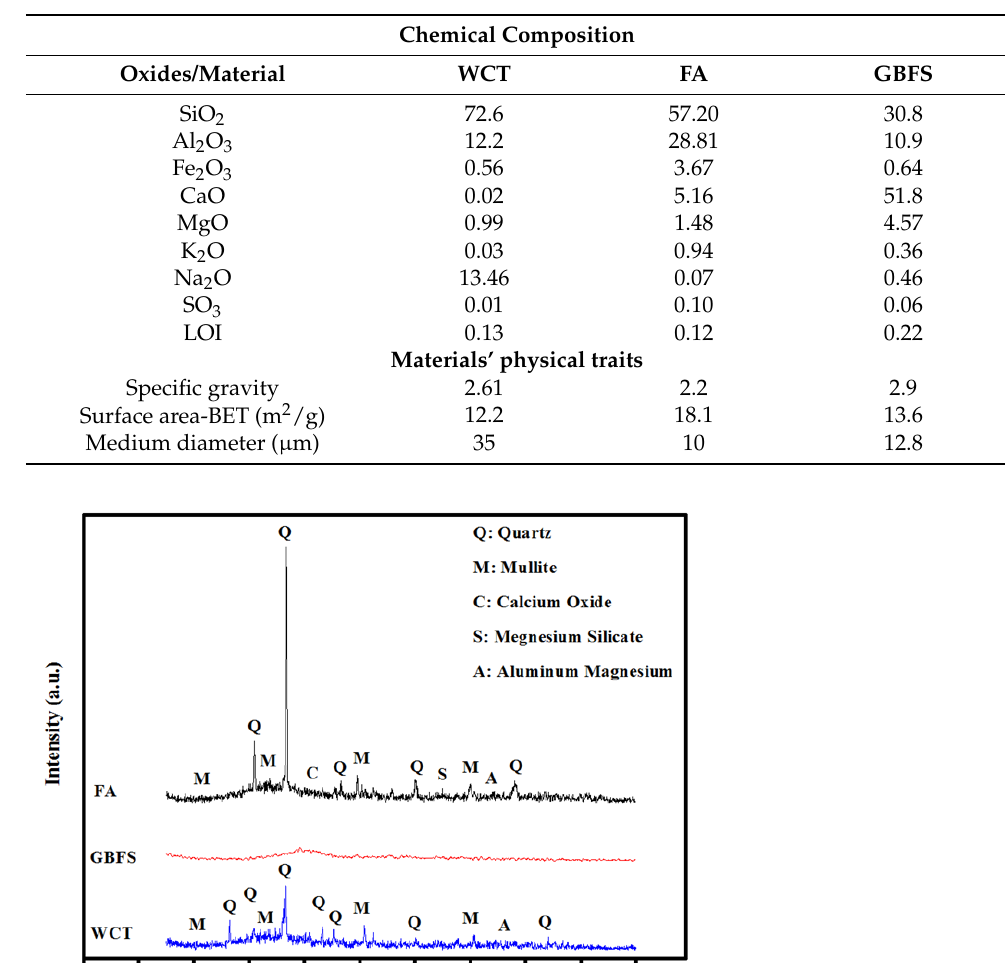
Table 2. Chemical and physical attributes of raw materials based on XRF test.